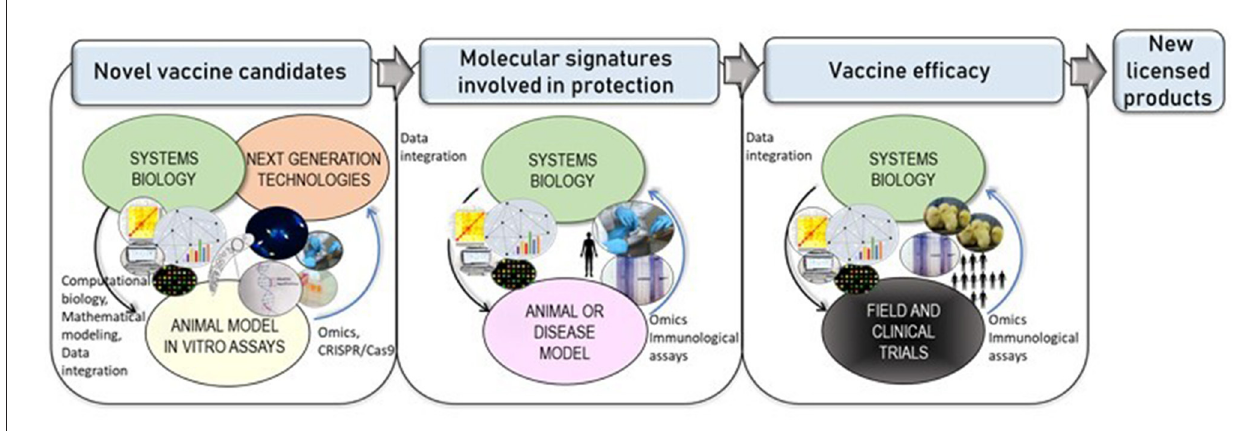
FIGURE 1 | Next-generation technologies and systems biology leading to novel vaccines. Cutting-edge technologies such as comparative “omics” or CRISPR/Cas9-based technologies allow functional characterization of genes with an hypothetical annotation. Systems biology approaches allow positive/negative dynamic feedback in an iterative process (indicated with blue arrows), by combining the use of data generated by molecular biology and high-throughput technologies with computational biology and mathematical modeling, have enabled the study of host immune responses and host-parasite interactions that could lead to the discovery of novel vaccine targets. Furthermore, systems biology applied to animal or disease model holds to the discovery of host immune signatures. Finally, upon vaccine design and experimental evaluation vaccines are evaluated under different formulations and regimens in animal/human models in controlled in vivo trials–i.e. field or clinical -, systems-based approaches will integrate immunological, experimental and “omics” data, assessing vaccine efficacy in the specific target populations, supporting further improvements and leading to new licensed products for apicomplexan